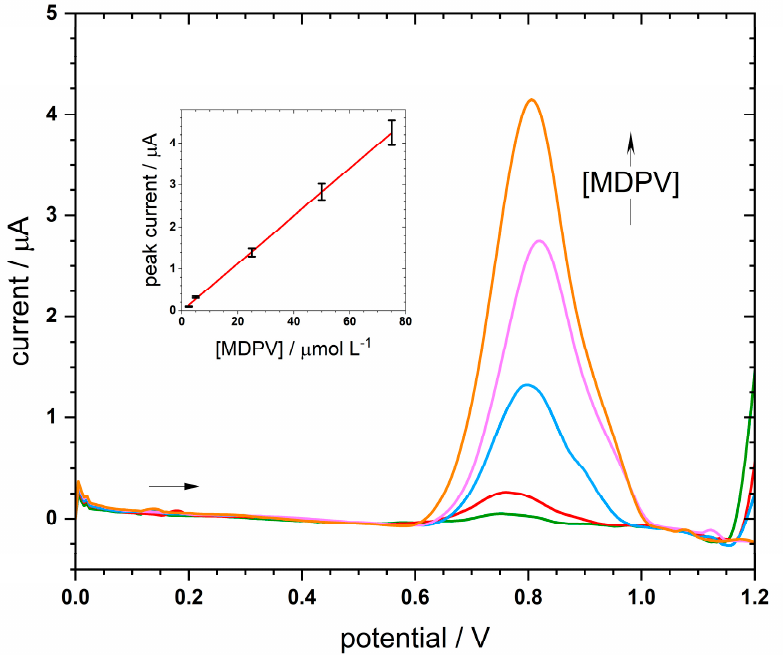
Figure 6. SWVs of different MDPV solutions, inlay the corresponding calibration curve.